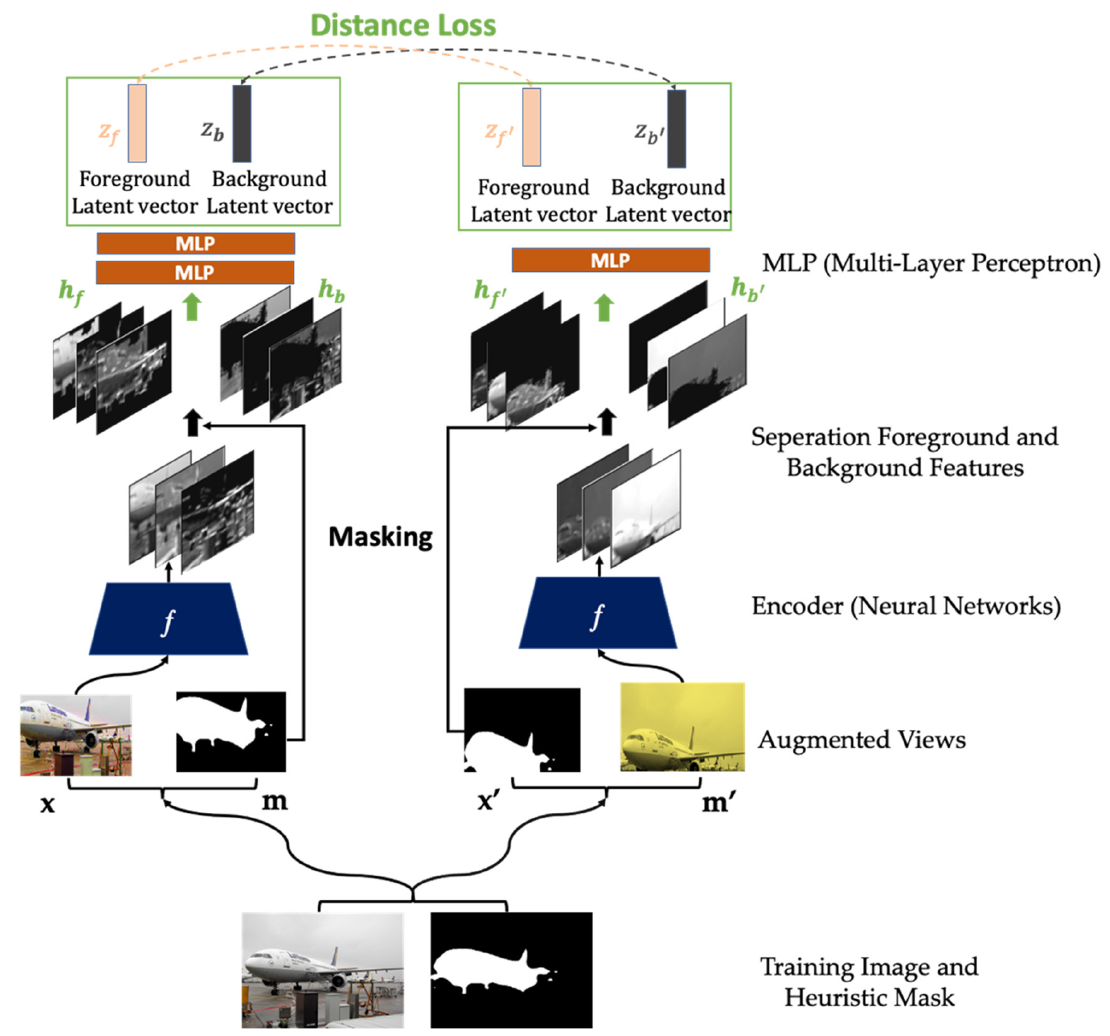
Figure 1. The HARL’s architecture. The heuristic binary mask can be estimated by using either conventional computer vision or deep learning approaches. After that, data augmentation transformation is applied to both the image and its mask ( bottom ). Then, the image pairs flow to a convolutional feature extraction module. The heuristic mask is used to mask the feature maps (which are the outputs of the feature extraction module) in order to separate the foreground from the background features ( middle ). These features are further processed by non-linear multi-layer perceptron modules (MLP). Finally, the similarity objective maximizes foreground and background embedding vectors across different augmented views from the same image ( top ).